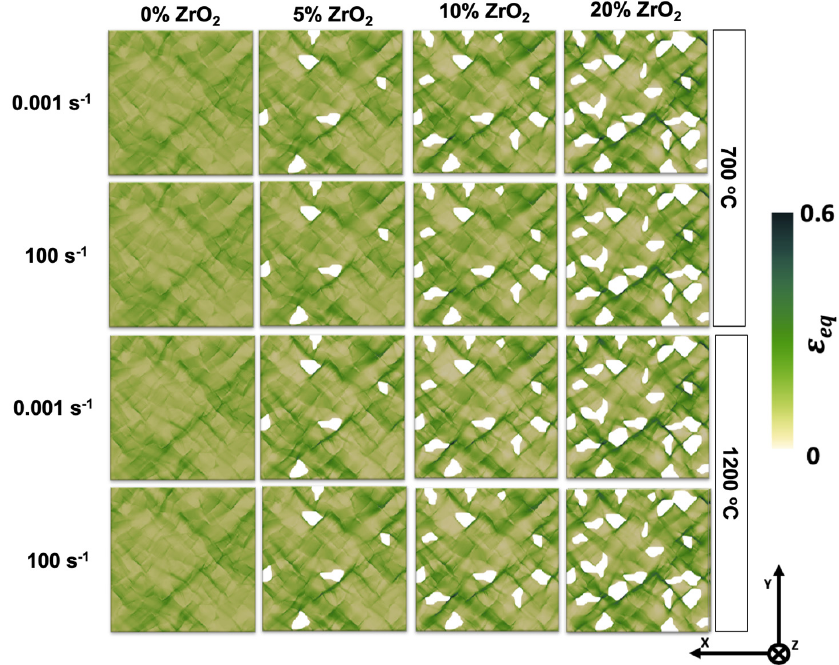
Figure 11. Local strain distribution maps at 0.1 true strain and 700 and 1200 °C for 0.001 and 100 s –1 strain rate.